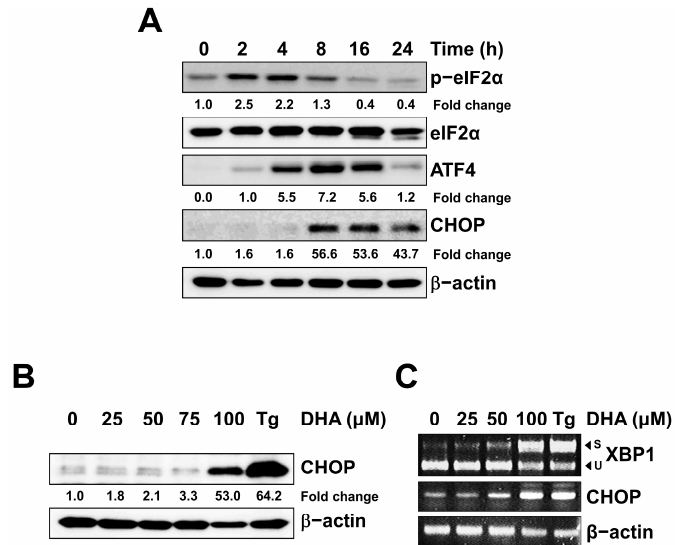
Figure 2. DHA induced the unfolded protein response in MH7A cells. Cells were treated with 130 μ M DHA for various periods, as indicated ( A ), or with various concentrations of DHA or 300 nM Tg for 24 h ( B ) or 12 h ( C ). ( A , B ) Cell lysates were subjected to SDS-PAGE, followed by immunoblot analysis using antibodies specific to the phosphorylated form of eIF2 α (p-eIF2 α ), eIF2 α , ATF4, CHOP, or β -actin. Blots have been cropped down to size for clarity. ( C ) Total RNA was isolated, fied XBP1 DNA fragments were digested with Pst I to distinguish the spliced (S) form and unspliced (U) form of XBP1 fragments, as indicated with